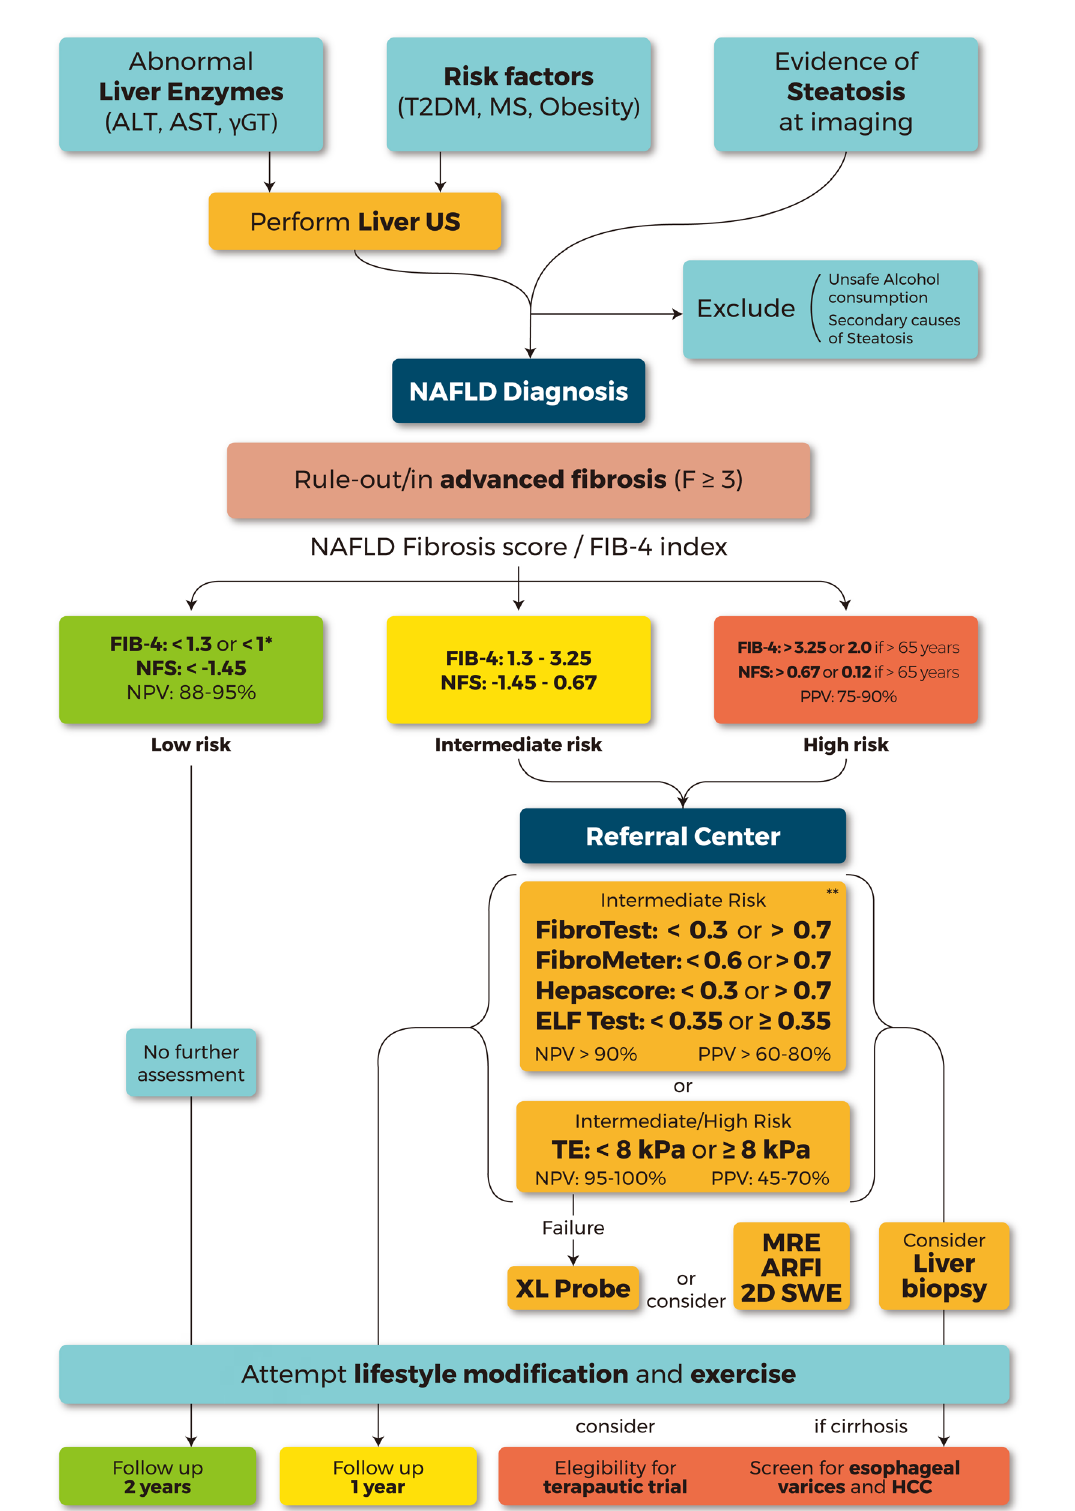
Figure 2. A proposed algorithm to be used by clinicians to perform the diagnosis and the risk stratification of patients with steatosis by means of non-invasive tests. The suspicion of NAFLD should be made in patients with metabolic risk factors [T2DM, obesity or MetS or abnormal liver test (AST, ALT, and GGT)]. The evidence of steatosis, identified at US imaging, allows NAFLD diagnosis only after excluding any secondary cause of steatosis. The subsequent risk stratification and the choice of the non-invasive test should be guided by the clinical context and, therefore, by local availability. In primary health-care settings, NFS and FIB-4, simple and inexpensive, should be used as first line, allowing ruling out patient with intermediate/high risk of AF with a high NPV (88-95%). FIB-4 < 1.3 or NFS < -1.45 identify low risk patients with simple NAFL that don’t need further assessments and may